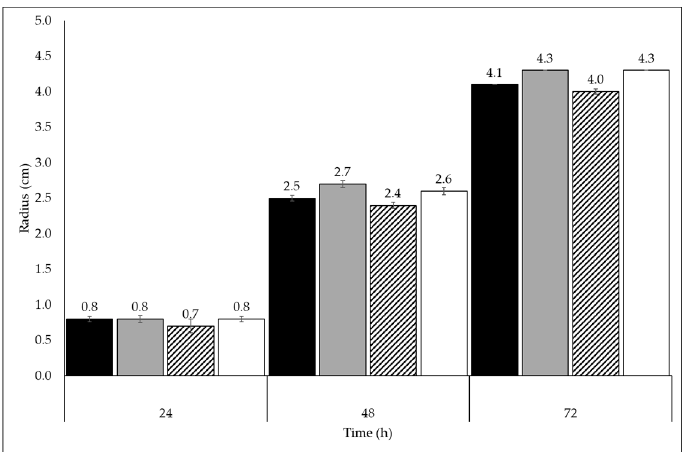
Figure 3. Radial growth of the Trichoderma sp . on FMWs plates. Trichoderma sp. was grown on Mandels medium supplemented with glucose (black bar), olive-mill solid waste (OMSW, gray bar), tomato pomace (TP, striped bar), and grape pomace (GP, white bar) at 0.5% as the sole carbon source. Error bars indicate the standard deviations (SDs) based on three different replicated experimental values. Numbers on the top of each bar indicate the average radius corresponding to mycelial growth.